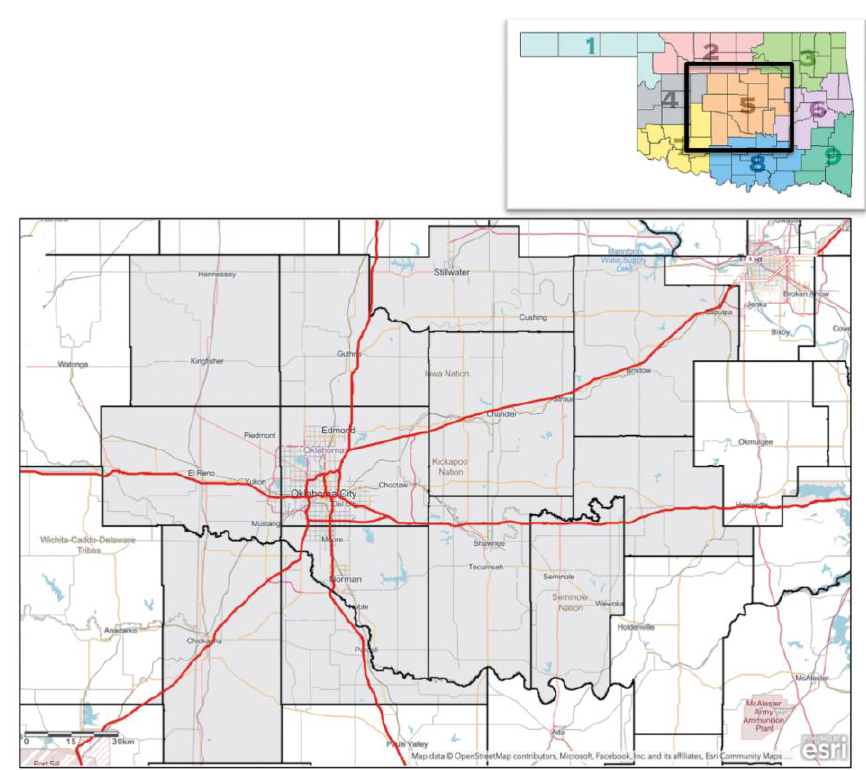
Figure 1. Main panel: Domain (light grey shading), covering Oklahoma Climate Division 5 and overlain with counties, select cities, and roads. White areas are outside the bounds of the domain. Map and base layers are courtesy of ArcGIS online. Subsidiary panel shows the location of the domain within Oklahoma State (image courtesy of the Oklahoma Climatological Survey).